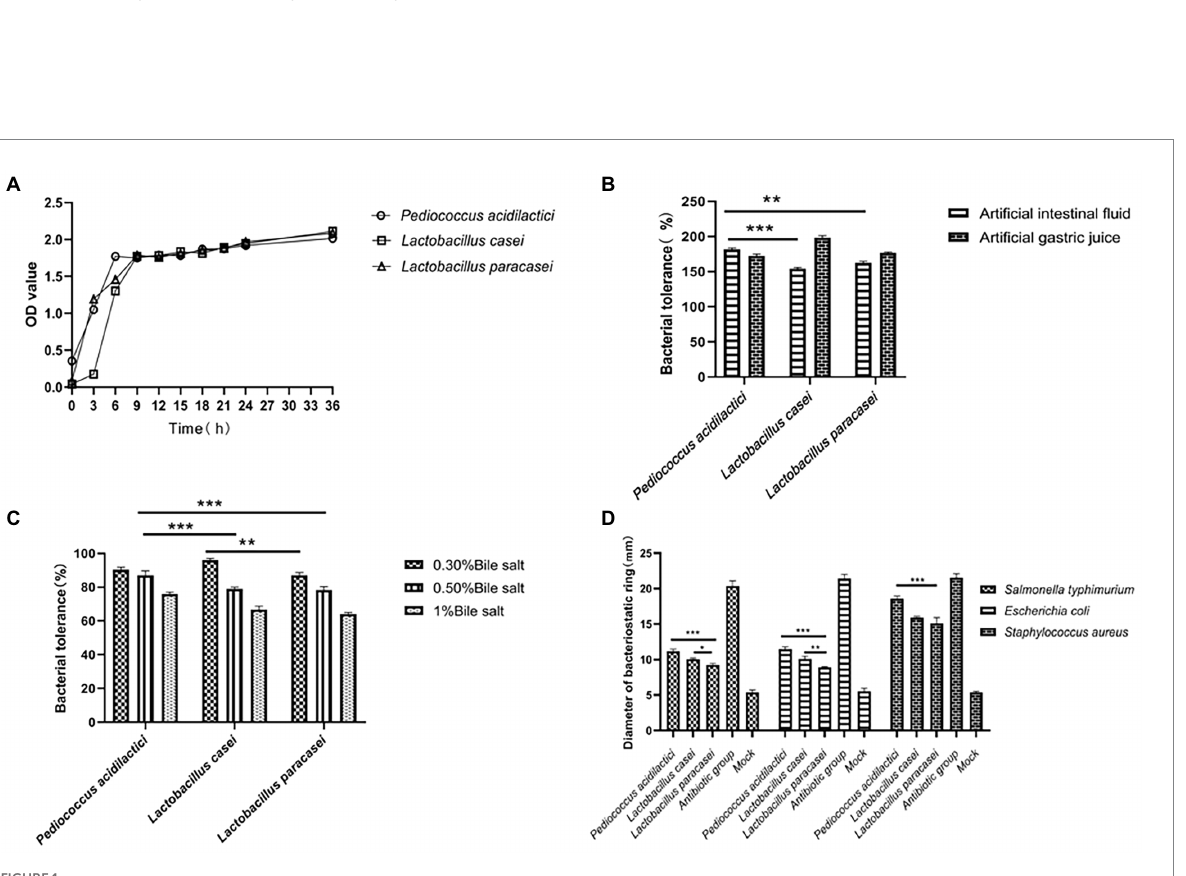
FIGURE 1 Growth characteristics and tolerance of isolated bacteria. (A) Growth curve of three isolated lactic acid bacteria. (B) Tolerance of three strains under artificial simulated intestinal fluid and gastric juice conditions. (C) Tolerance of three strains of bacteria under different concentrations of bile salt. (D) Inhibitory effects of three strains on three pathogens (the pathogenic bacteria were Escherichia coli , Salmonella and Staphylococcus aureus